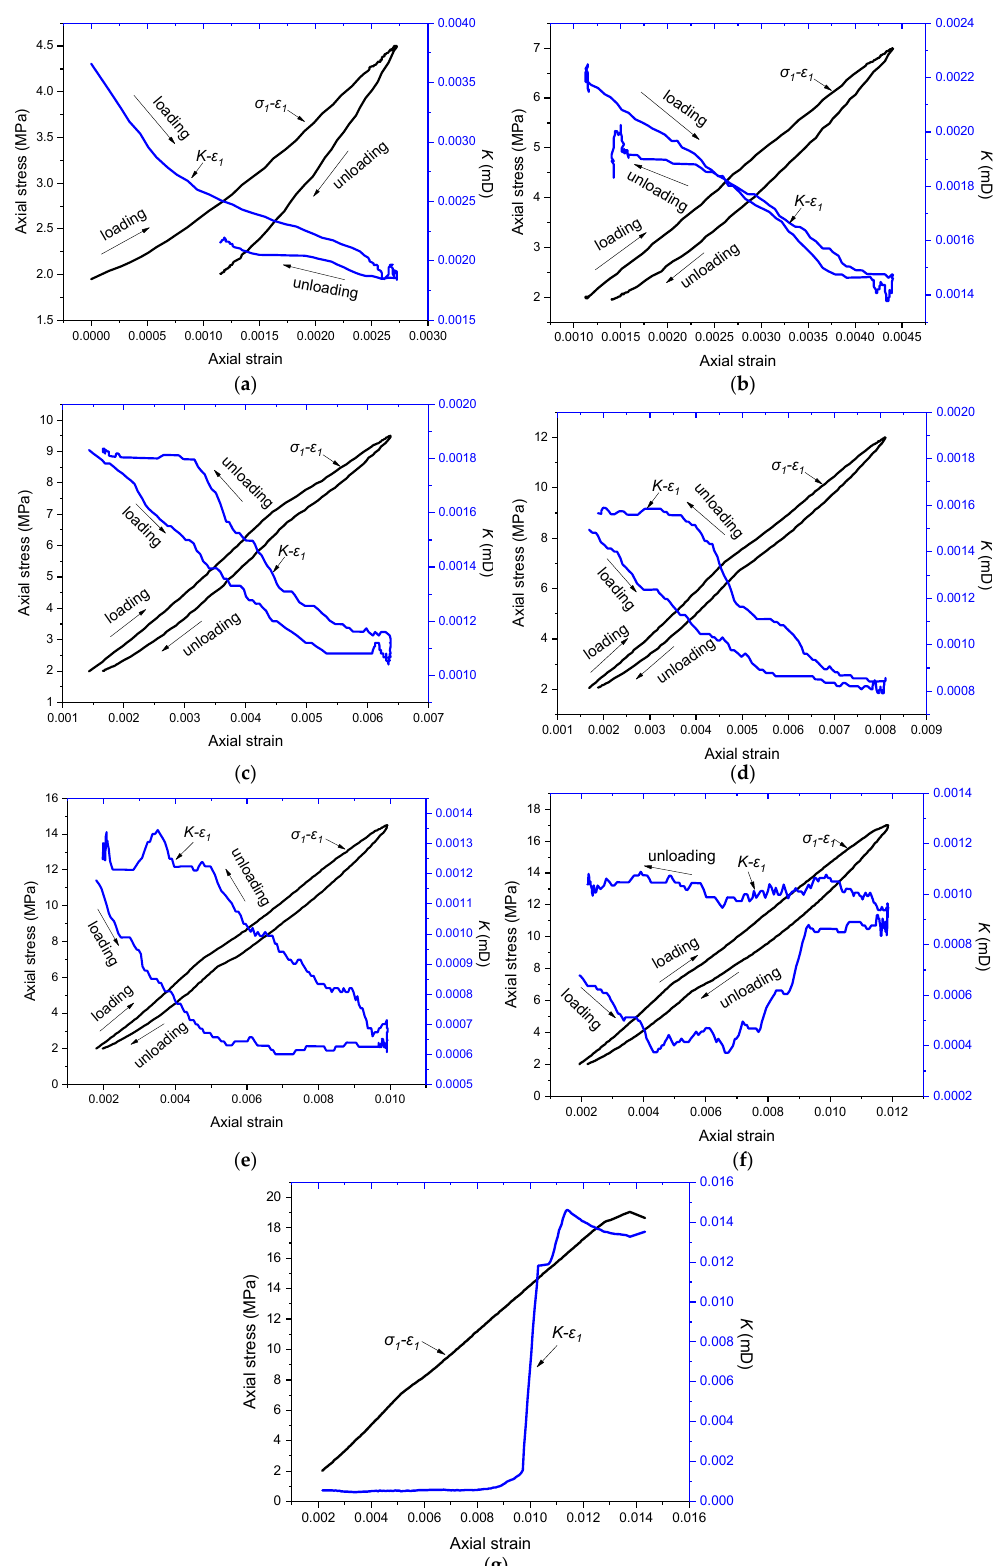
Figure 9. The axial stress–axial strain and permeability–axial strain curves of raw coal during each cycle under stress path 2. ( a ) The first cycle. ( b ) The second cycle. ( c ) The third cycle. ( d ) The fourth cycle. ( e ) The fifth cycle. ( f ) The sixth cycle. ( g ) The seventh